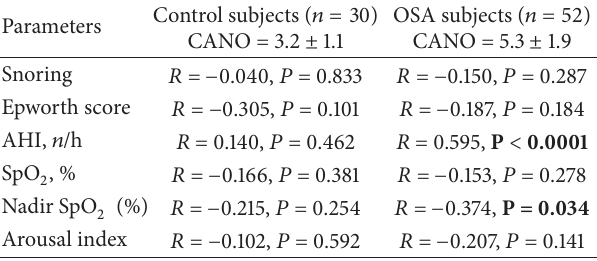
Table 3: Correlations between CANO and snoring, Epworth score, and PSG parameters.